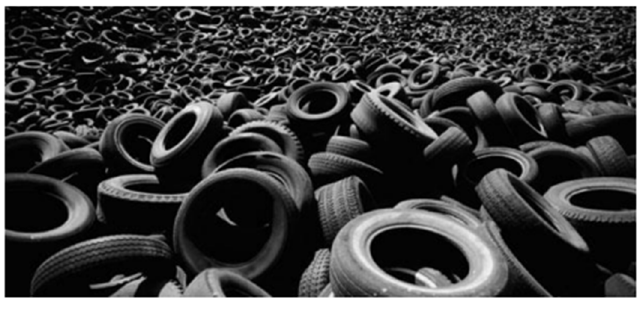
Figure 2. Waste tyres.